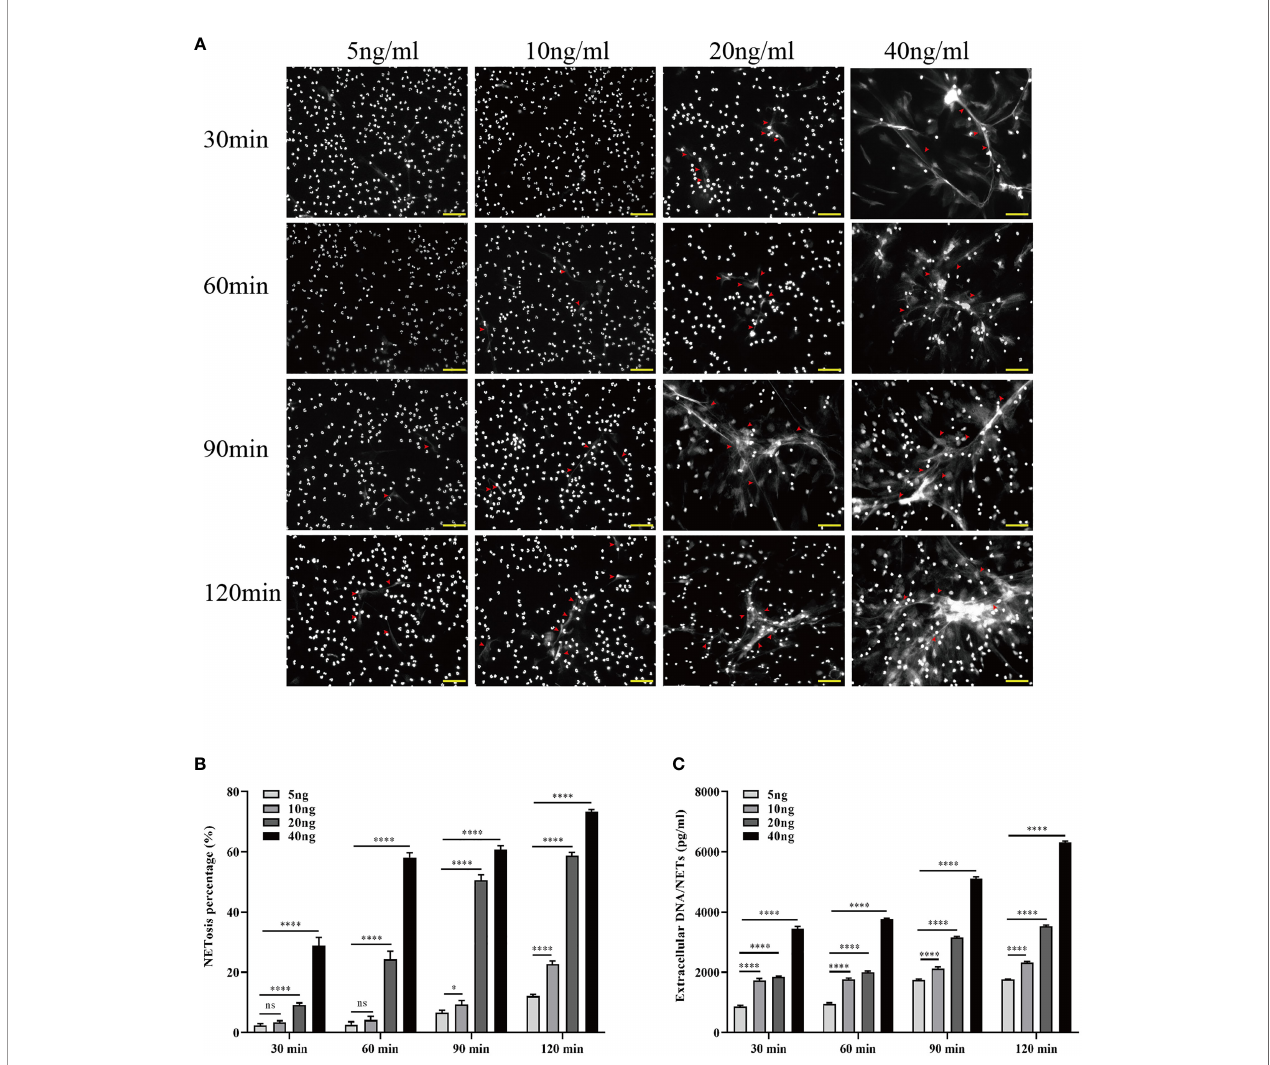
FIGURE 5 | Increased HMGB1 induces more NETosis in vitro . (A) Induction of NETosis in neutrophils from healthy individuals using different concentrations of HMGB1 (5, 10, 20, 40 ng/ml) at various time points (30, 60, 90, 120 min). (B) Quanti fi cation of neutrophil NETosis percentage. (C) Extracellular DNA/NETs were quanti fi ed every 30 min over a period of 120 min. n = 6. Differences were determined using one-way ANOVA. ns P > 0.05, * P < 0.05, *** P < 0.001, **** P